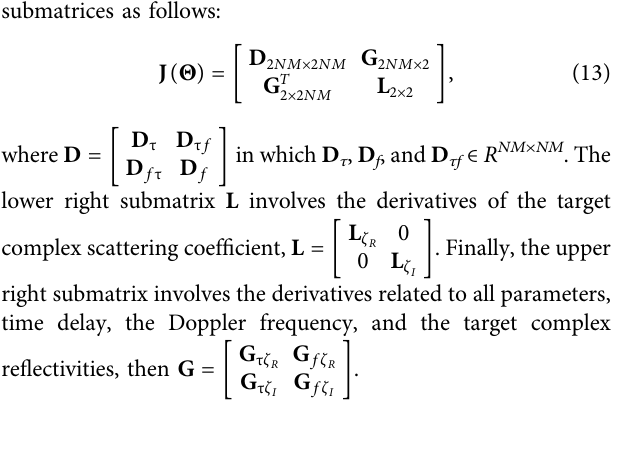
Frontiers in Signal Processing |